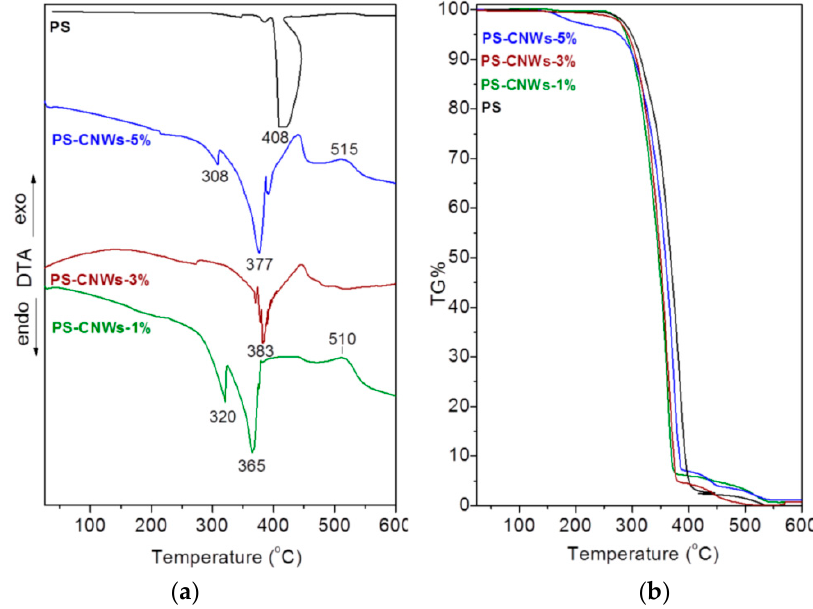
Figure 6. DTA ( a ) and TGA ( b ) curves of neat PS and two nanocomposites at 1 and 5% CNWs